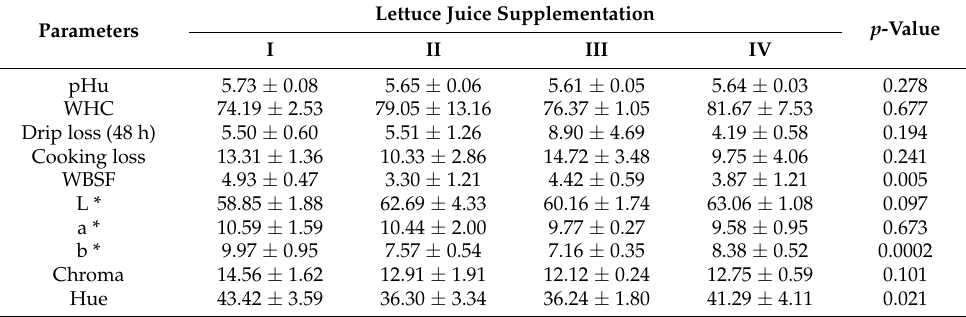
Table 10. Meat quality characteristics of rabbits administered lettuce juice fertilized with nitrate or WHP (groups III and IV, respectively) as compared to that of nonfertilized lettuce or lettuce-free diet (groups I and II, respectively).